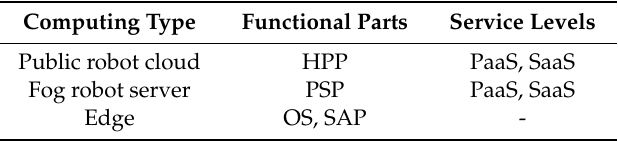
Table 1. The characteristics computing of